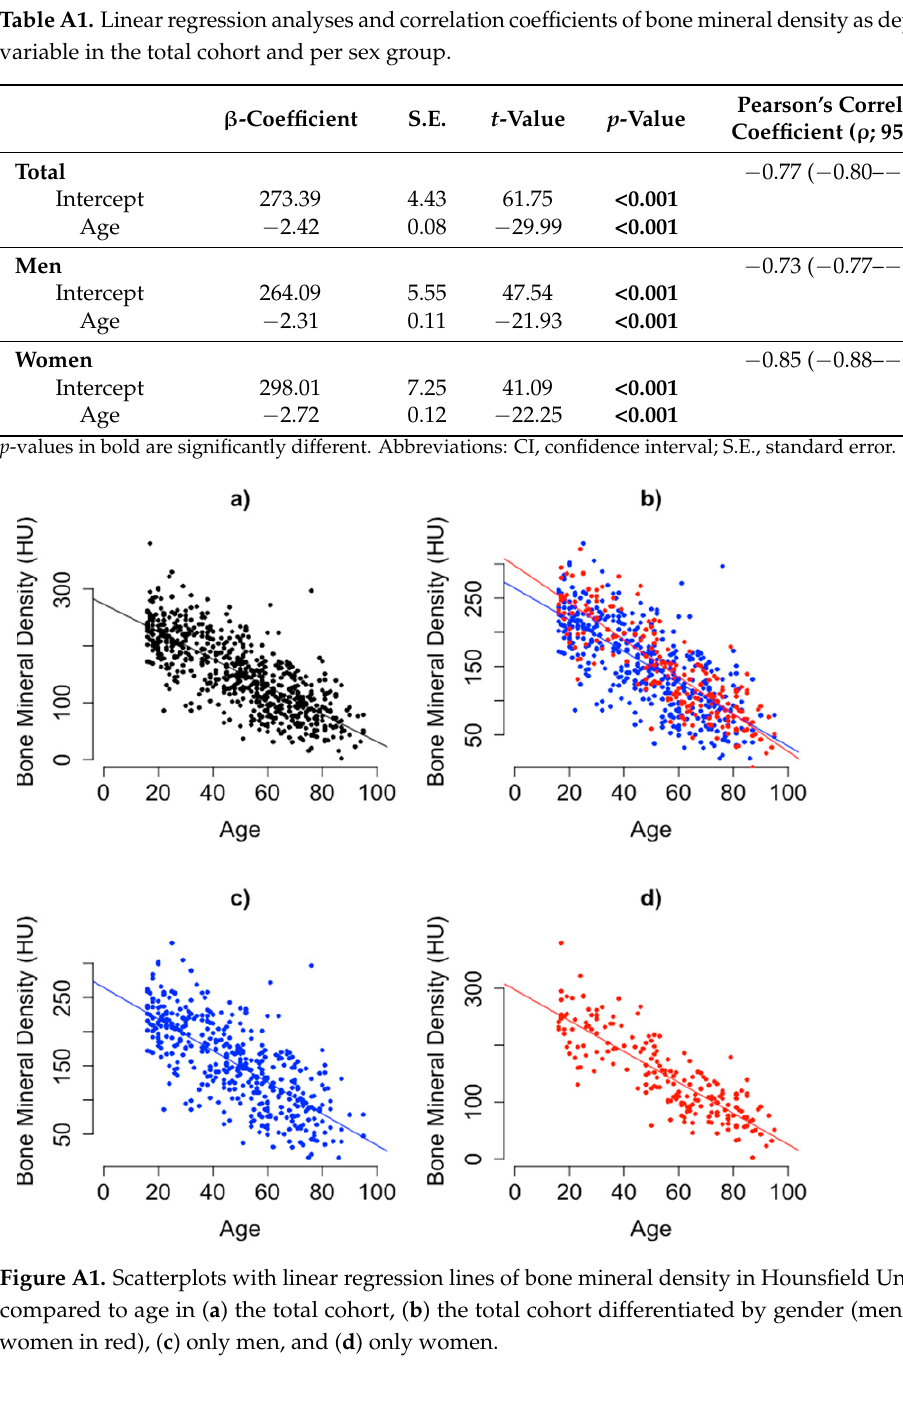
Table A1. Linear regression analyses and correlation coefficients of bone mineral density as dependent variable in the total cohort and per sex group.